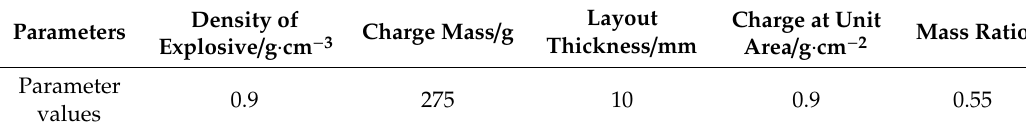
Figure 2. Schematic diagram of explosive compression structure device. Table 3. Parameters of explosion compression bonding of 6061-Q235a.